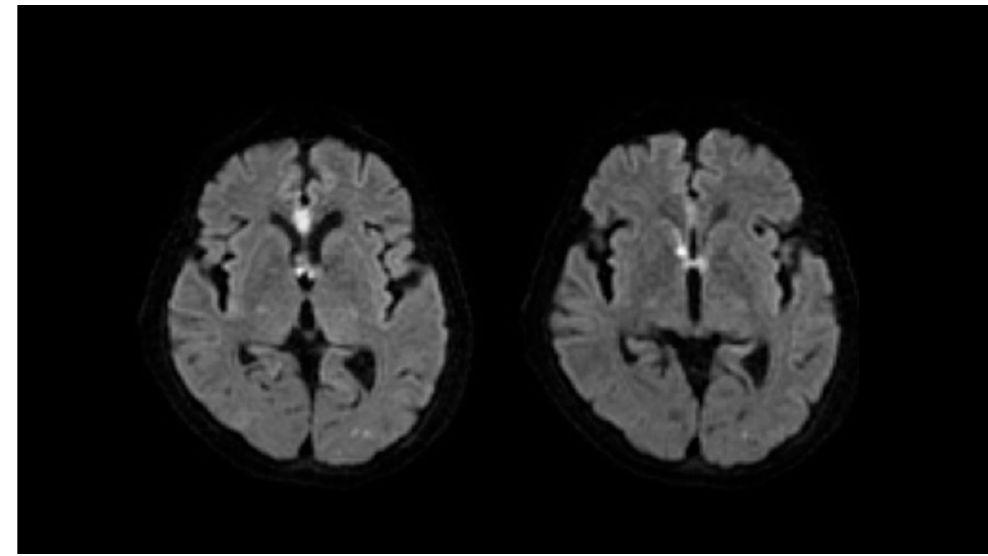
Figure 3. Diffusion-weighted imaging after coil embolization; in our case, high-intensity areas are seen at the anterior corpus callosum and bilateral fornix.